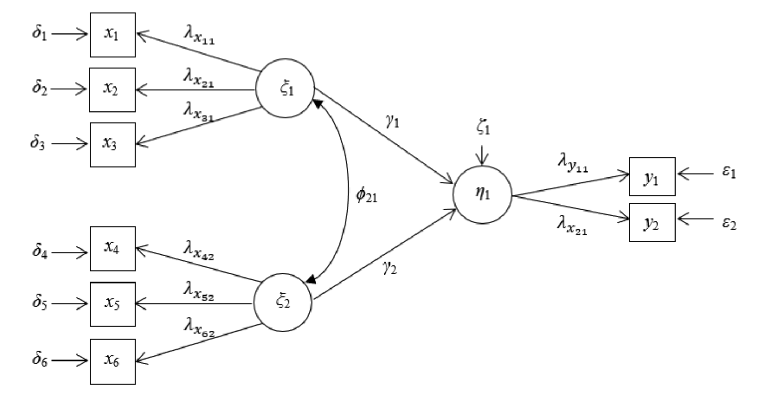
Figure 2. General structural